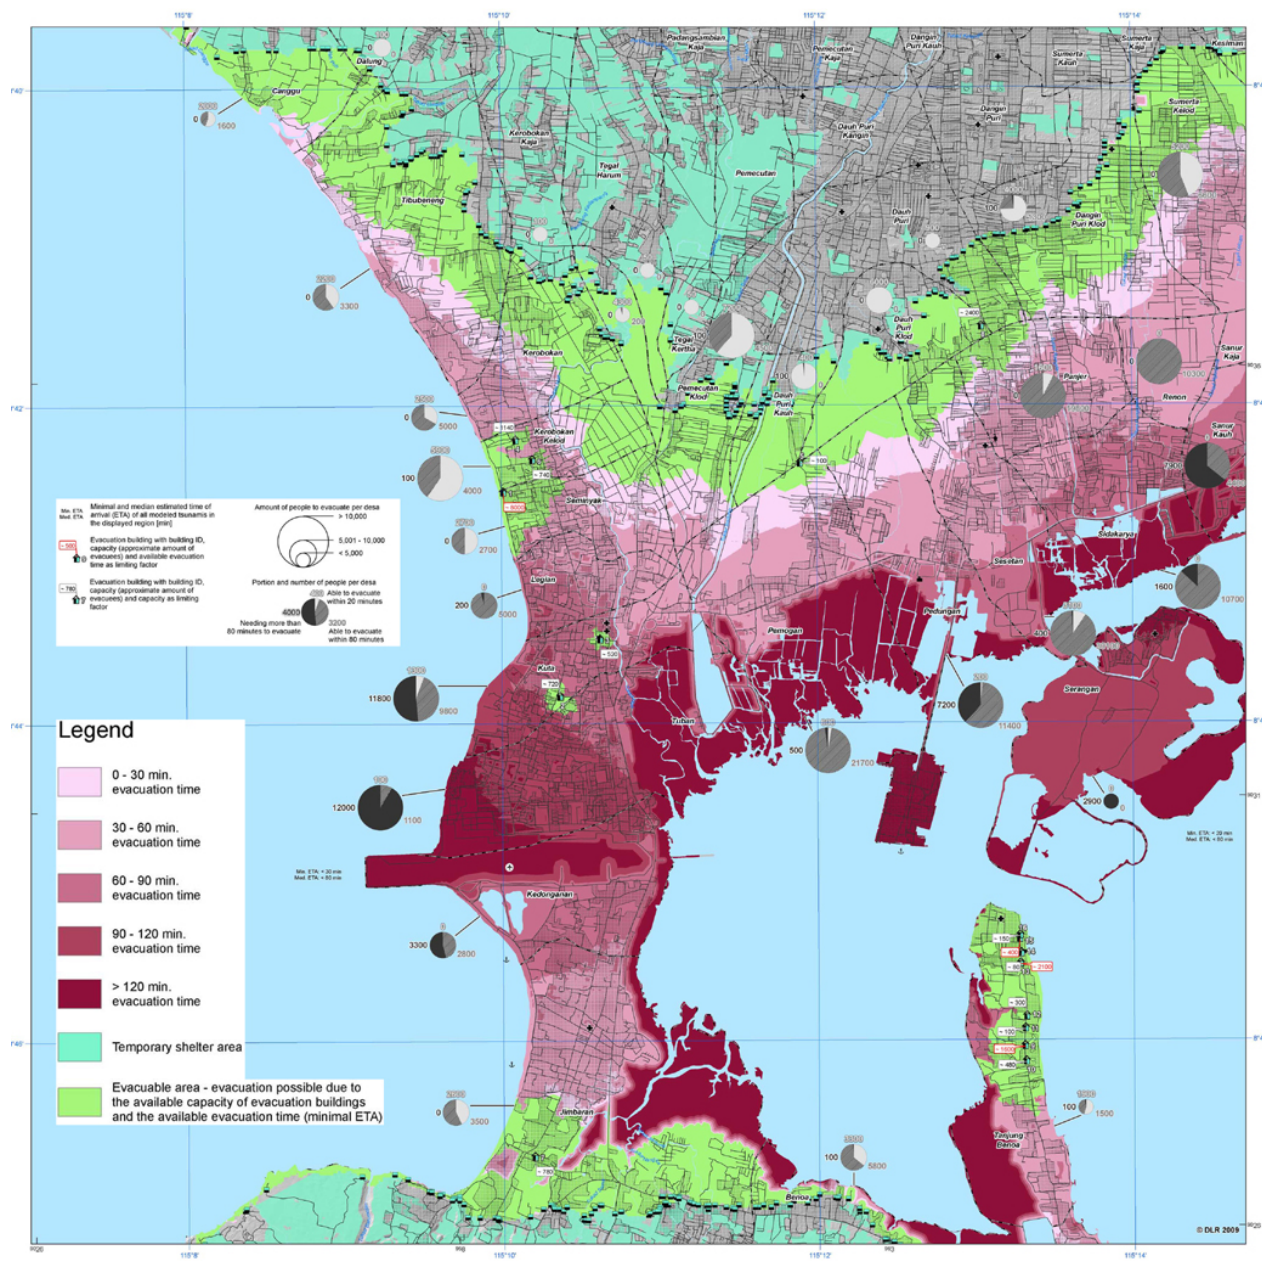
Fig. 12. Evacuation time map of Kuta